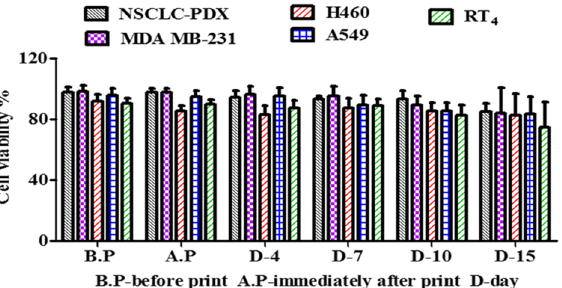
Figure 3. Biocompatibility of Ink H4-RGD. Ink H4-RGD biocompatibility in NSCLC-PDX, RT4, MDA-MB-231, H460 and A549 cell lines before printing, immediately after printing, on Day 4, Day 7, Day 10 and Day 15 by counting cell viability through NIH ImageJ software (1.43u; https ://image j.nih.gov/ij). Results shown were representative of three independent